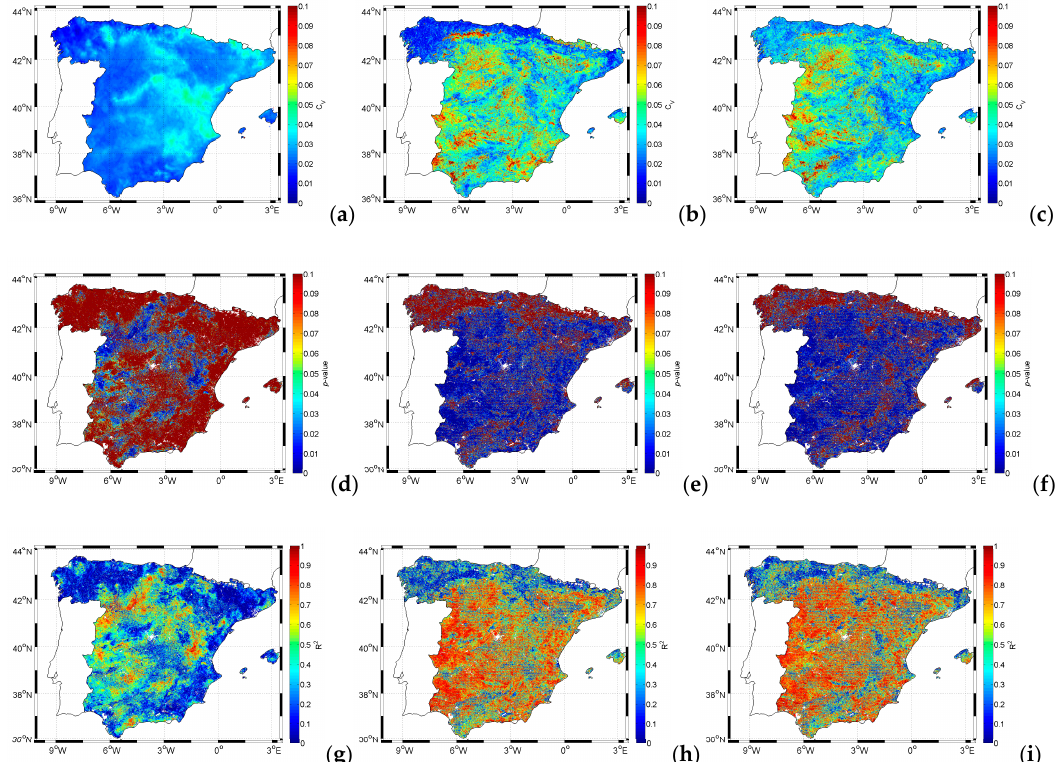
Figure 3. Coefficient of variation among the eight-year dataset of: ( a ) annual PAR; ( b ) annual mean NDVI; and ( c ) annual mean EVI. p -value of correlations between inter-annual variations for the eight years of annual GPP and those from: ( d ) annual PAR; ( e ) annual mean NDVI; and ( f ) annual mean EVI. R 2 for the above correlations: ( g ) GPP/PAR; ( h ) GPP/NDVI; and ( i ) GPP/EVI.